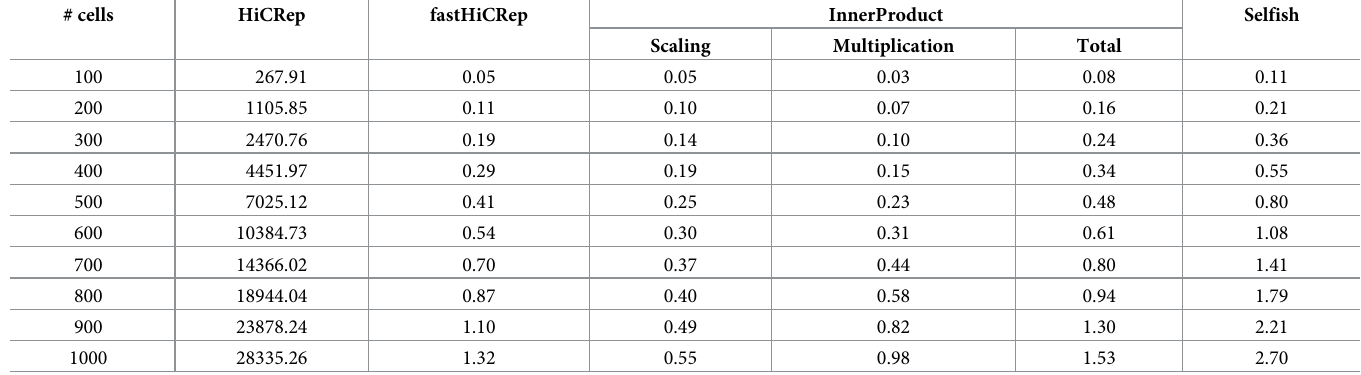
Table 1. Average run time (in seconds) of different methods as the number of cells vary. (Run time is averaged from 10 replicate experiments, performed on an Intel Xeon W-2175 CPU with a frequency of 2.50GHz). #